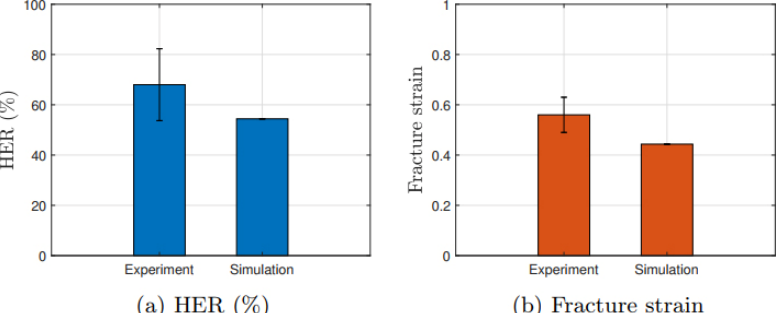
Fig. 15 Comparison of experimental and simulated (a) HER values and (b) fracture strains for monotonic loading condition. Reproduced with permission from Ref. [9], © CIRP 2020.